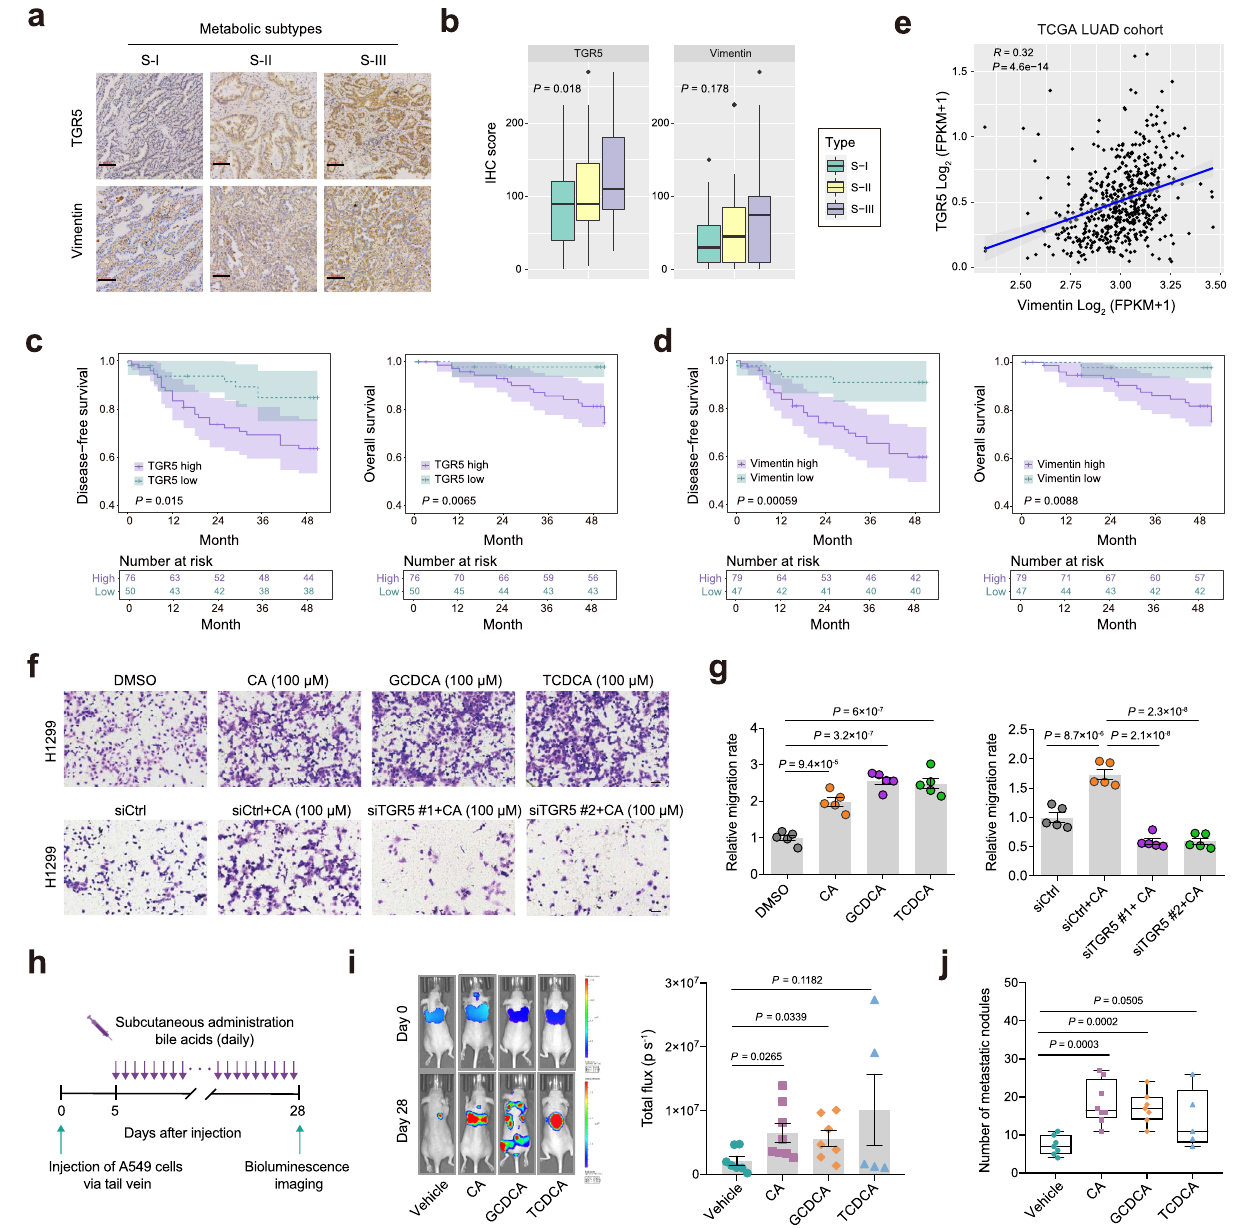
Fig. 6 Aberrant bile acid metabolism promotes migration of invasive LUAD. a Representative image of immunohistochemical staining of TGR5 and vimentin on 126 IAC patient tumor from S-I ( n = 33), S-II ( n = 63), and S-III ( n = 30) subtypes. Scale bar, 100 μ M. b Immunohistochemical (IHC) score of TGR5 and vimentin from patients in S-I ( n = 33), S-II ( n = 63), and S-III ( n = 30) subtypes. A two-sided One-way ANOVA test was used. The centerline represents the median, and the box bounds represent the inter-quartile range. The whiskers span 1.5-fold the inter-quartile range. c Kaplan-Meier curves comparing the disease-free survival and overall survival in IAC patients with a high group (histoscore > 80 in TGR5 expression) versus low group (histoscore ≤ 80 in TGR5 expression). A two-sided log-rank test was used. d Kaplan-Meier curves comparing the disease-free survival or overall survival in IAC patients with a high group (histoscore > 20 in vimentin expression) versus low group (histoscore ≤ 20 in vimentin expression). A two-sided log-rank test was used. e The correlation plot of TGR5 with vimentin expression with signi fi cant Pearson ’ s correlation in TCGA LUAD dataset ( n = 525). R, Pearson ’ s correlation coef fi cient. f , g Transwell migration assays were performed on H1299 cells treated with CA (100 μ M), TCDCA (100 μ M), and GCDCA (100 μ M) or treated with CA (100 μ M) and transfected with or without siTGR5. Representative images (left, scale bar, 100 μ m) for three biological repeats and statistical analyses (right, n = 5) of the migrated cells are shown. siCtrl, siControl. Data represent the mean ± s.e.m. and One-way ANOVA followed by Tukey ’ s multiple comparison test was used. h Diagram showing the experimental design for in vivo metastasis assay (see Methods). i Lung metastasis assay of A549-luciferase cells treated with indicated bile acids (Vehicle, n = 7; CA, n = 8; GCDCA, n = 7; TCDCA, n = 5, example mice shown to left). j Quanti fi cation of the metastasis nodules on the pulmonary surface of each groups (Vehicle, n = 7; CA, n = 8; GCDCA, n = 7; TCDCA, n = 5). In i and j , data represent the mean ± s.e.m. and two-tailed Student ’ s t -test was used.